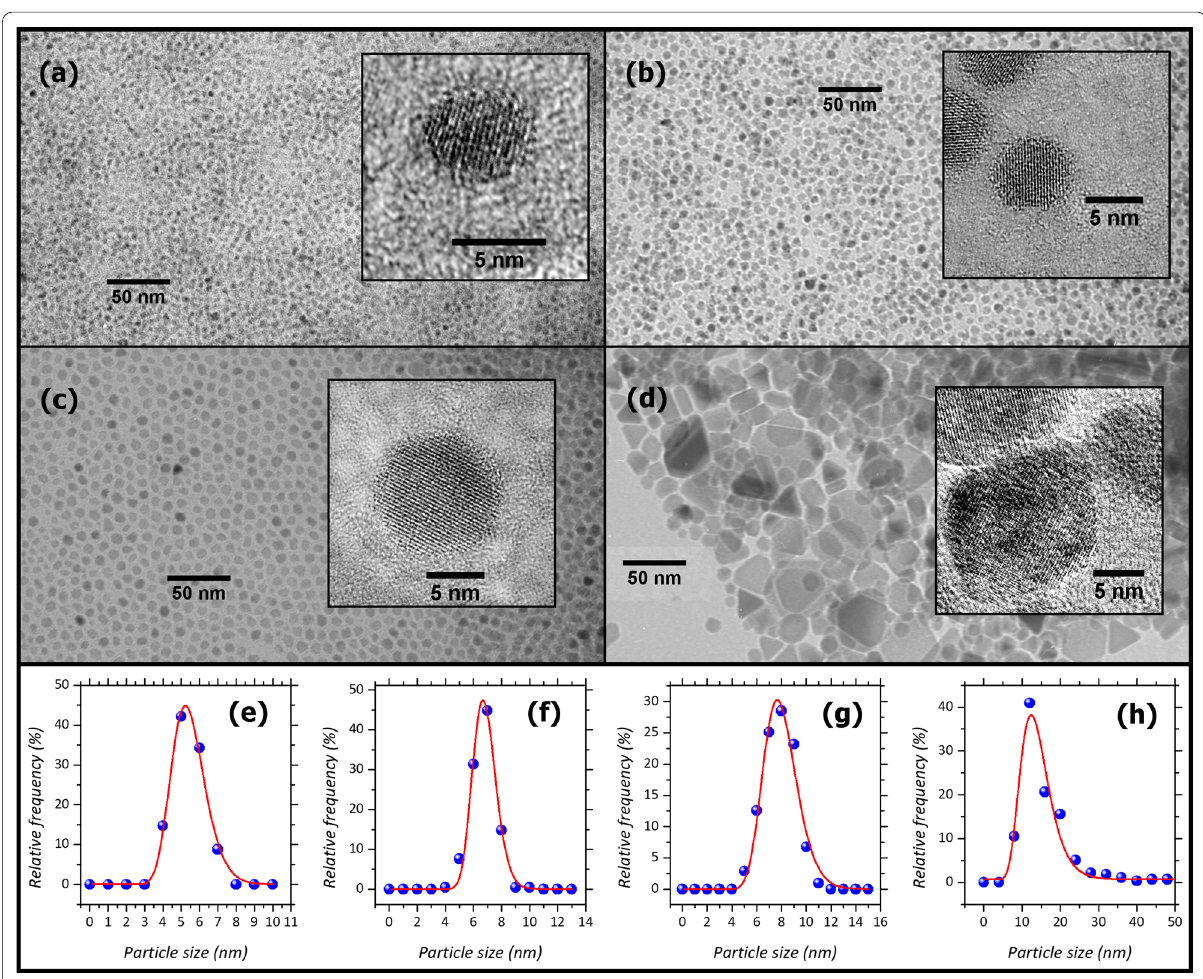
Fig. 1 TEM images of MAG1 ( a ), MAG2 ( b ), MAG3 ( c ), and MAG4 ( d ), with inset high-resolution images of single particles representative of the morphology and crystallinity of the samples. The corresponding particles’ size distributions are reported in panels e , f , g , and h for MAG1, MAG2, MAG3, and MAG4, respectively. The frequency counts of the measured size are represented as blue spheres, while the continuous red line describes the log-normal fit to the data